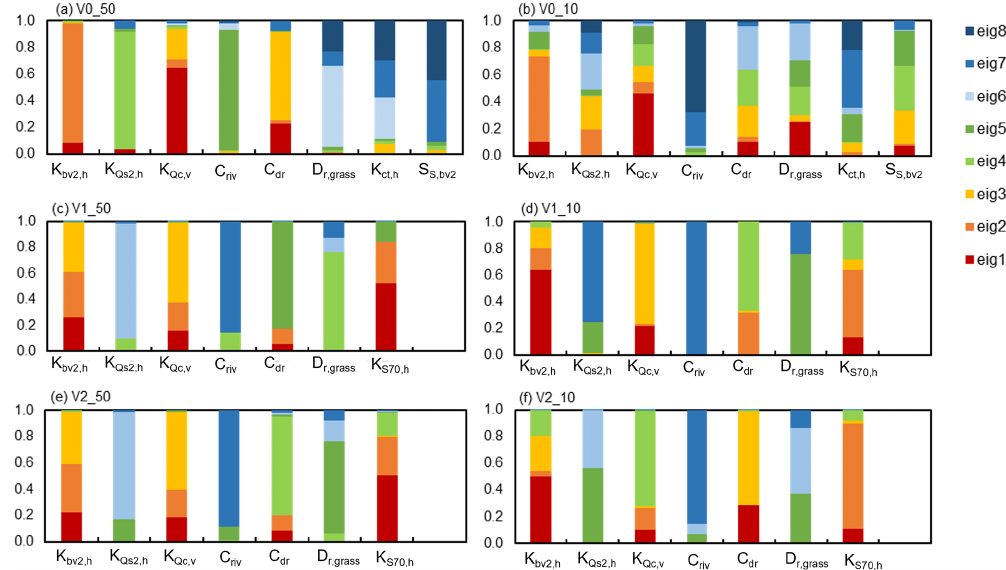
Figure 11. Parameter identifiability without the truncation of the solution space. The colors indicate the contribution made to the total identifiability by different eigenvectors in the solution